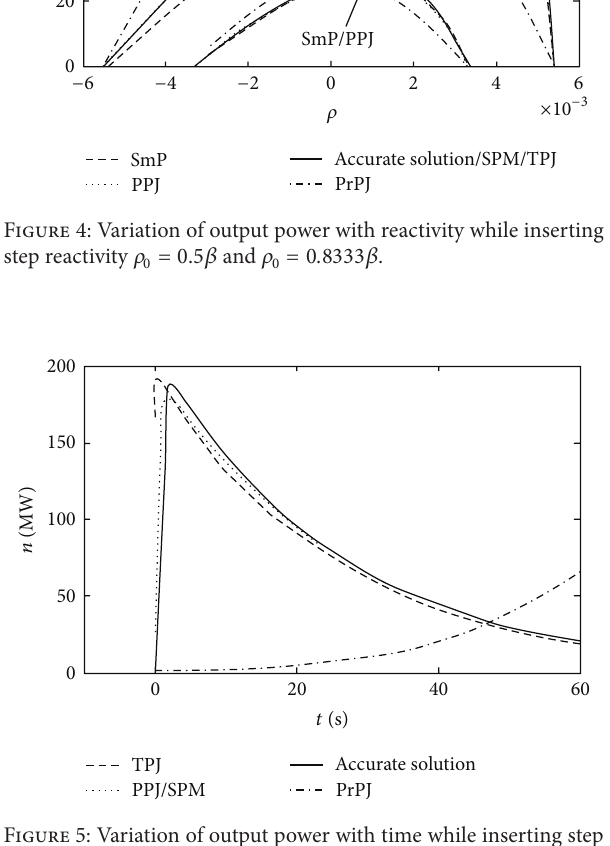
Figure 5: Variation of output power with time while inserting step reactivity 0.995𝛽